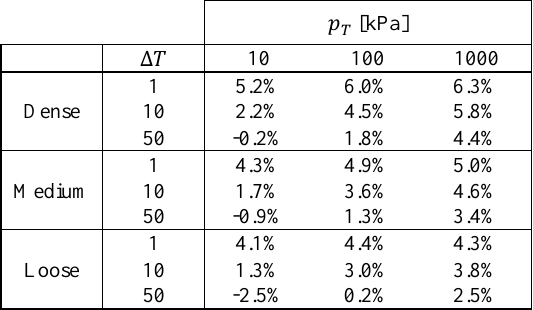
Table 5 . Differences in Δ𝑝 Δ𝑇 values ( Fix case).